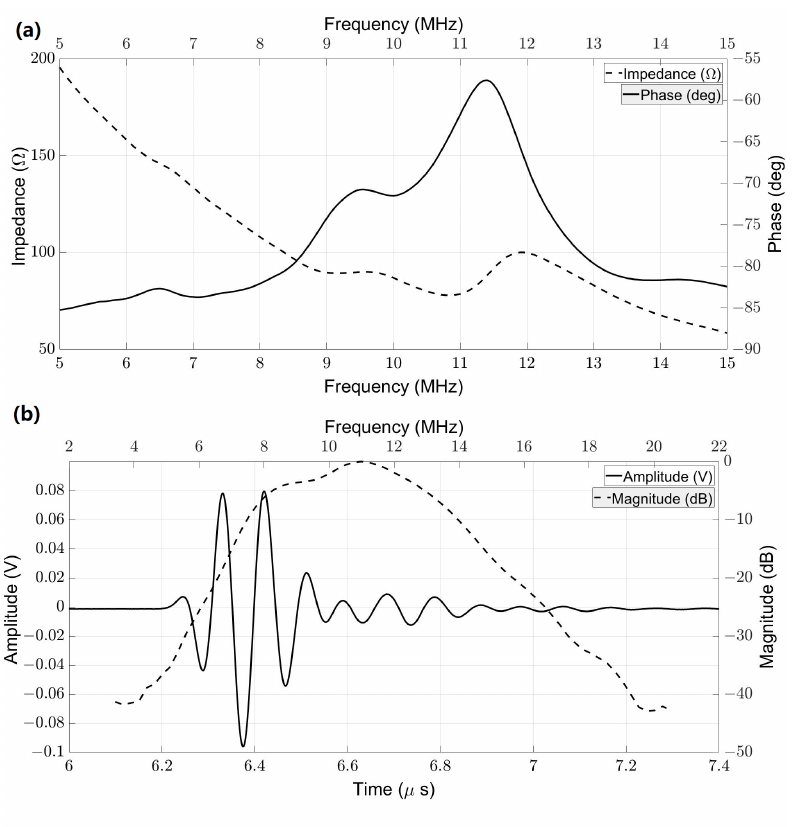
Figure 7. Transducer characterizations element #10: ( a ) measured electrical impedance and ( b ) pulse-echo response of element #10. Table 1. Acoustic characterizations of 16